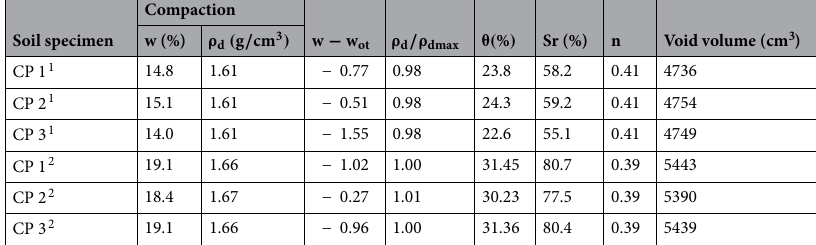
Table 3. Soil samples compaction conditions and phase relationships. 1,2 : samples from first and second sampling